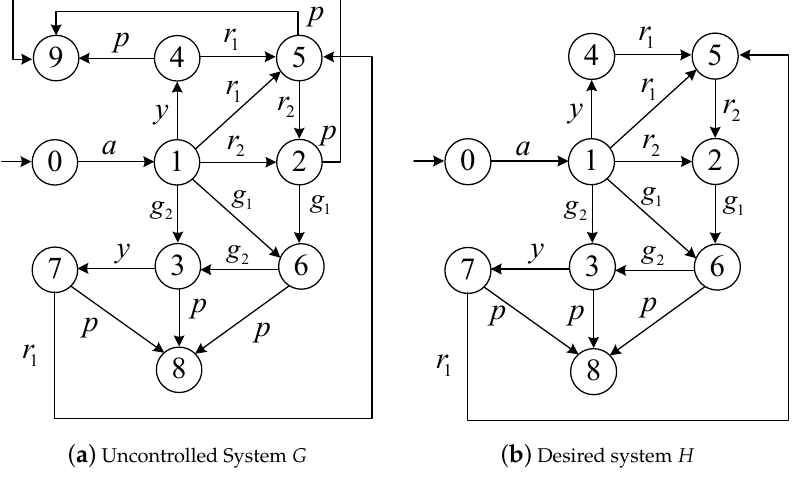
Figure 8. System G and desired system H